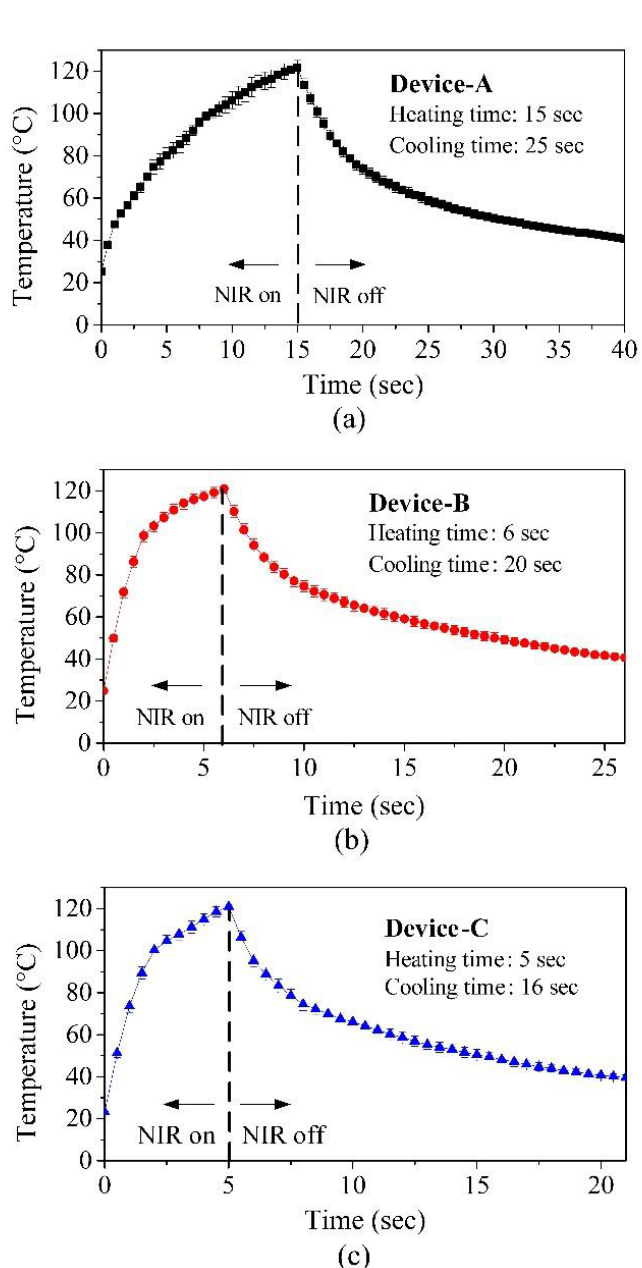
Figure 8. The transient temperature responses of ( a ) Device-A, ( b ) Device-B, and ( c ) Device-C as a function of time with the NIR light illumination (808 nm, 2.4 W/cm 2 ). Table 2. The dimensions of the LCE devices for locomotion